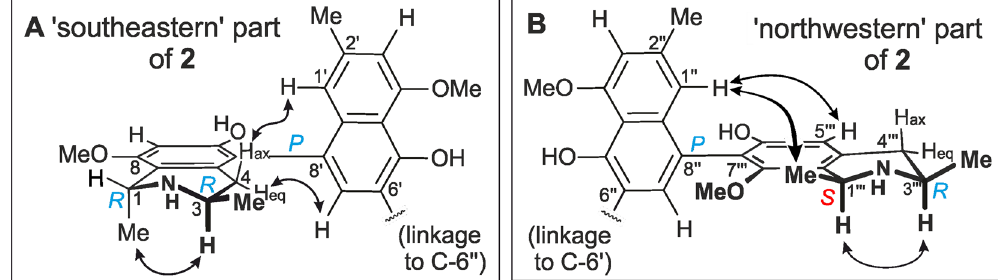
Figure 5. ROESY interactions indicative of the relative configurations at the stereogenic centers and axes within the northwestern ( A ) and southeastern ( B ) molecular halves of ealapasamine B ( 2